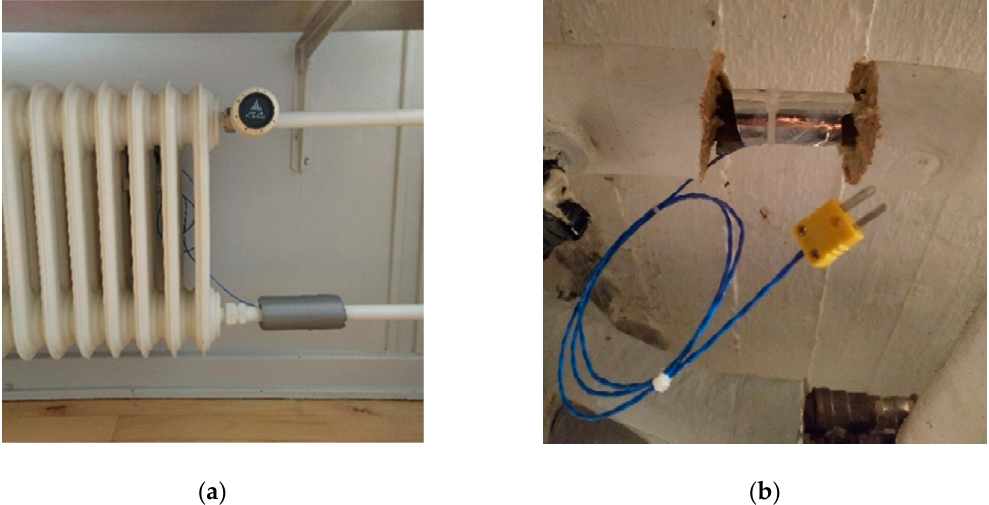
Figure 13. ( a ) Thermocouple attached to the return pipe of a radiator element in an apartment; ( b ) Thermocouple attached to the return pipe and a riser in the basement before it is covered with insulation.